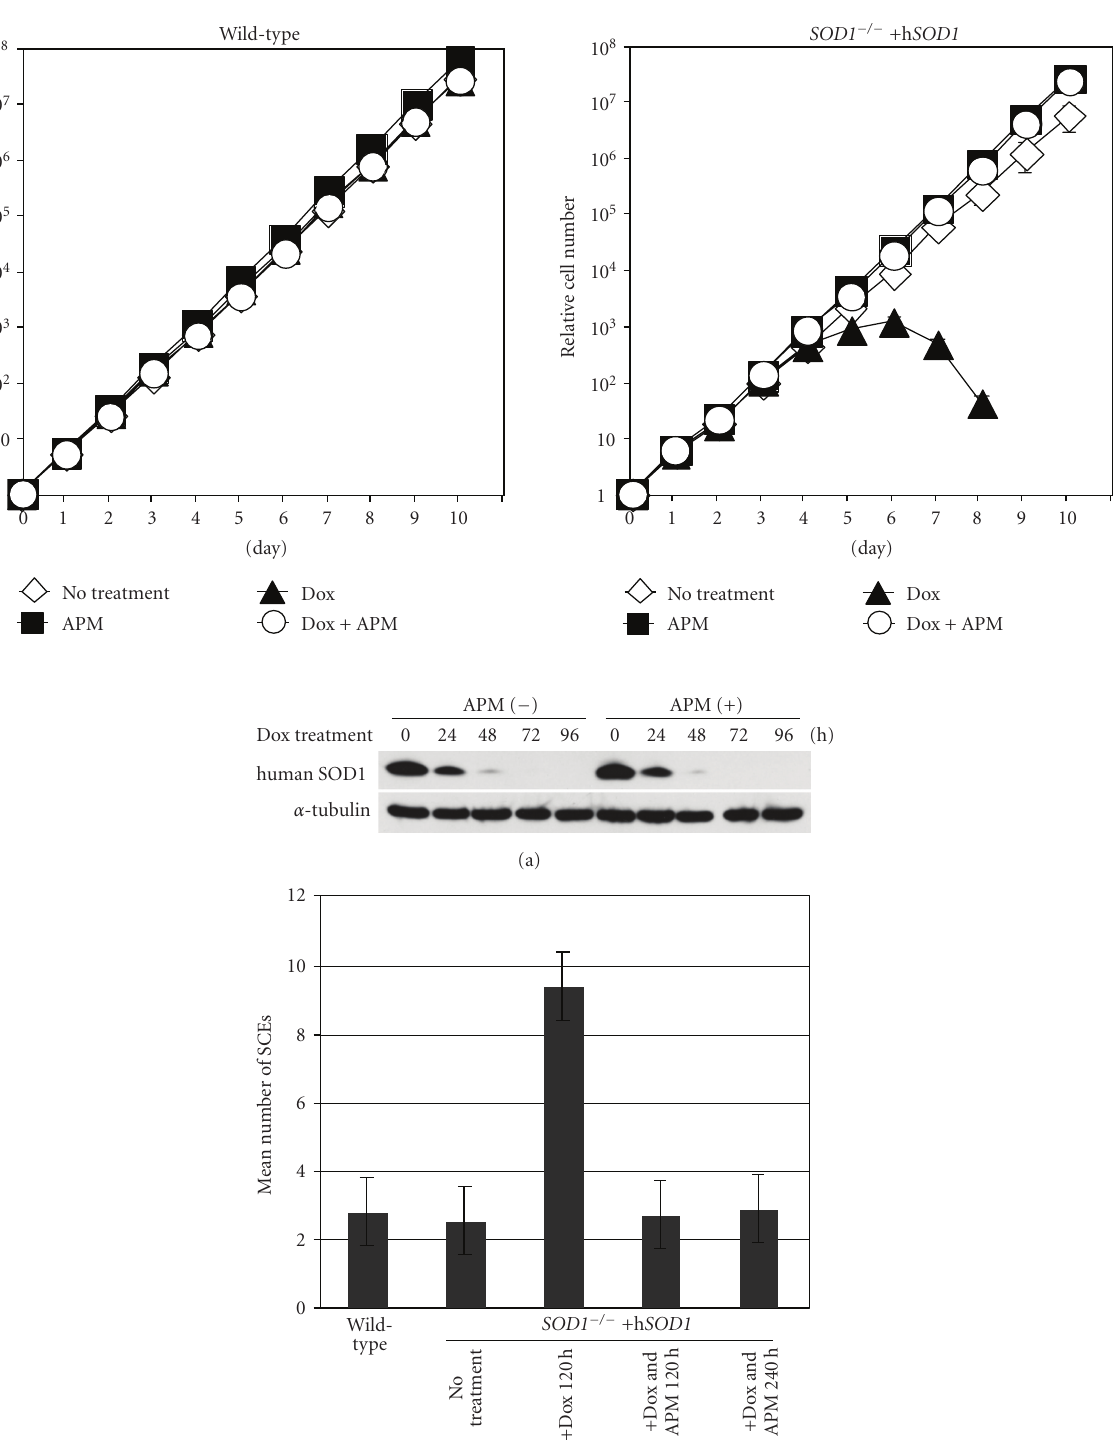
Figure 4: Suppression of lethality and increase in SCE frequency in cells depleted of SOD1 by APM (a) Upper panel: growth curves of cells of the indicated genotypes. Cells were cultured with or without 1 μ g/mL Dox and/or 200 μ M APM. Lower panel: disappearance of hSOD1 was confirmed by western blotting. (b) SCE frequencies of cells treated with Dox and APM for 0, 120, or 240 hours. A total of 100 metaphase cells was counted in each sample. Bars indicate standard